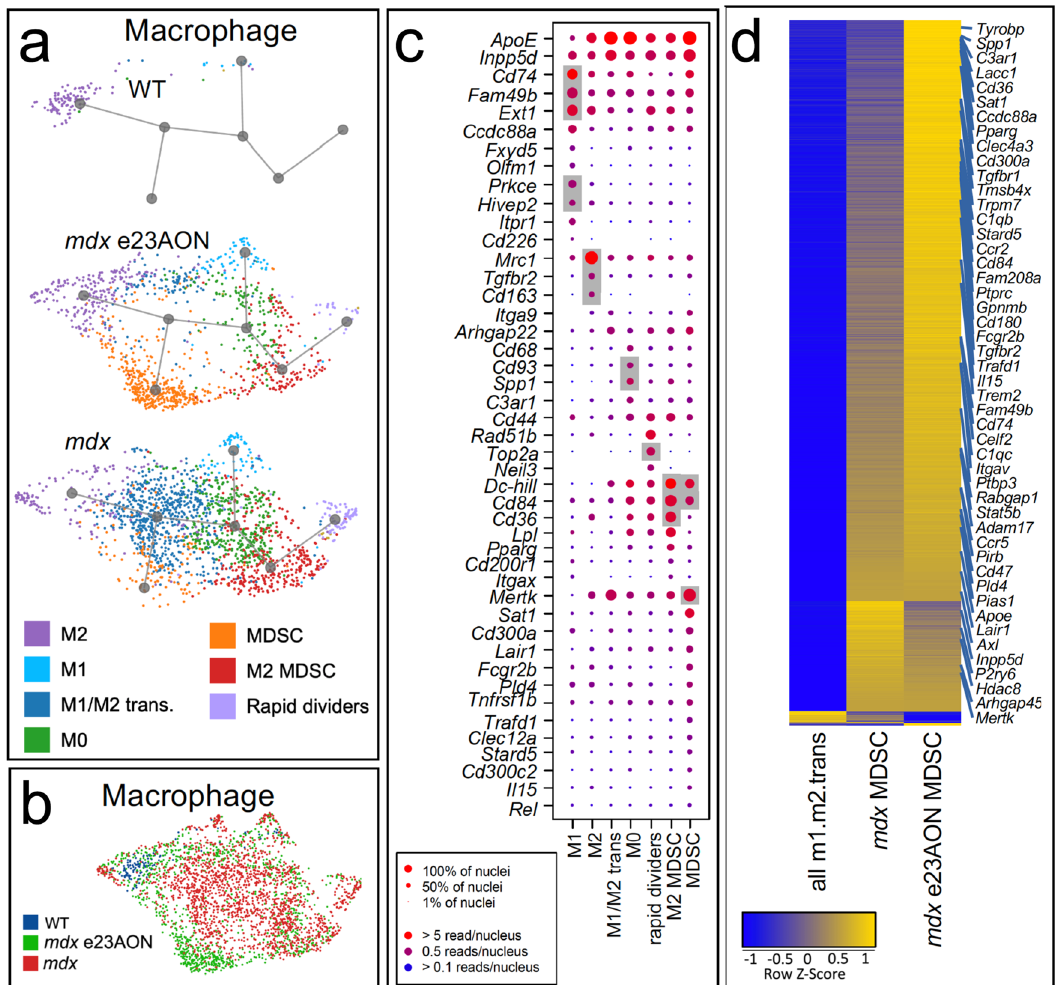
Fig. 4 Expansion of anti-in fl ammatory macrophage populations with dystrophin loss and rescue. a U-map pseudotime analysis and lineage tracing of macrophages reveals subset types for WT ( n = 3), mdx e23AON ( n = 4), and mdx ( n = 4). Macrophage subtypes are arranged according to their transcriptional relatedness and each subcluster color is matched to the legend for cell types shown in a and c . b Macrophage nuclei are organized as in a but color coded by mouse source as indicated. Gray background indicates known markers of the respective cell type on x -axis. c Gene expression for selected genes characterizing macrophage cell subset populations identi fi ed in a . (Complete list of signi fi cantly different genes is found in Supplementary Data 2). Dot size indicates percent of nuclei expressing the gene, dot color indicates level of expression. d Heatmap of gene expression changes across macrophage subsets and treatment conditions, including total M1/M2 transitional, MDSC from mdx , and MDSC from mdx e23AON, which are signi fi cantly expanded compared to untreated mdx . Yellow indicates higher gene expression. Heatmap shows the upregulation of MDSC characteristic genes as cells progress form M1/M2 transitional to mdx MDSC, and a further increase within MDSC with e23AON treatment ( mdx